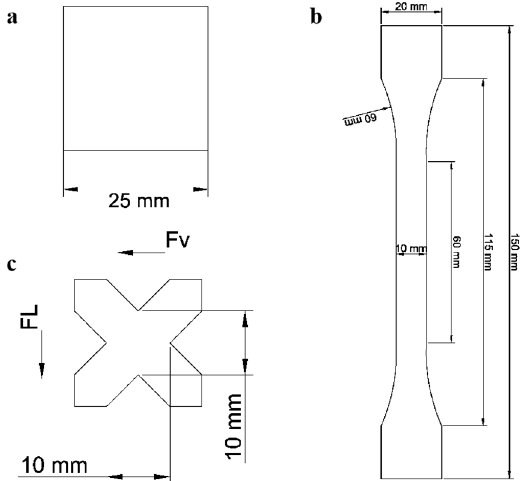
Figure 2. The cut shape of an extrudate used to determine hardness and springiness ( a ), tensile properties ( b ), and shear properties ( c ). properties ( b ), and shear properties ( c